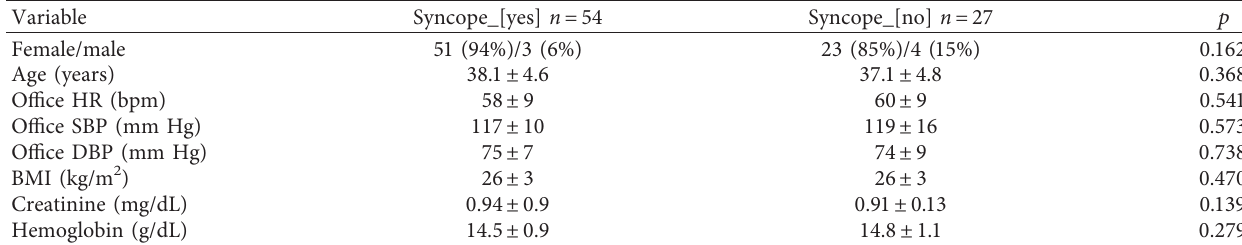
Table 1: Intergroup comparison of baseline characteristics.